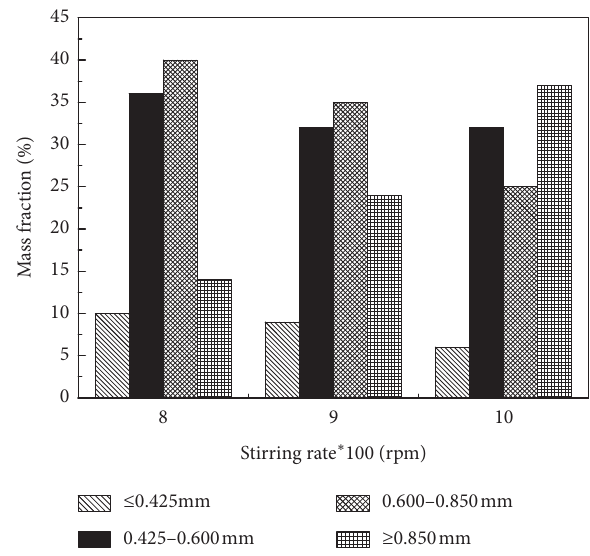
Figure 13: Effect of different phase ratios on crystal size distribution.